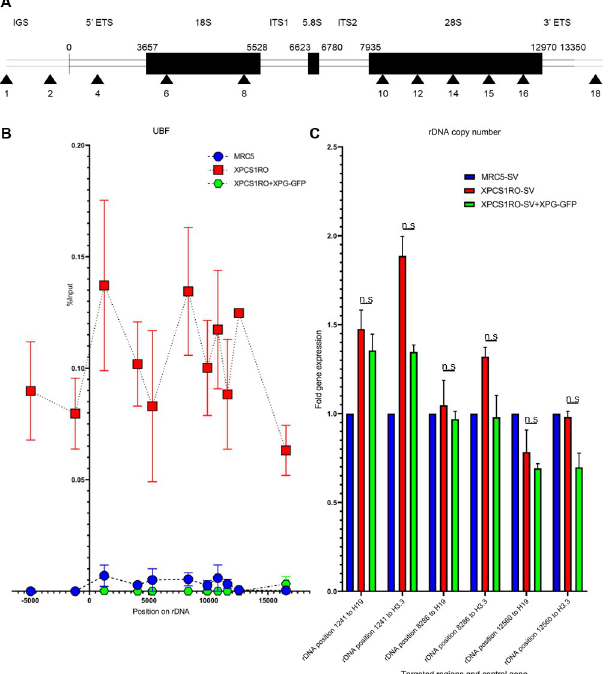
Fig 2. The absence of a stable XPG protein leads to an increased binding of UBF along rDNA unit. A) Scheme of the human rDNA unit with the position of all the primers used. IGS: InterGenic Spacer; ETS: External Transcribed Spacer; ITS: Internal Transcribed Spacer. B) ChIP-qPCR using UBF antibody in MRC5-SV, XPCS1RO-SV and XPCS1RO-SV+XPG-GFP cell lines. Signal was quantified as percentage of input DNA. Error bars represent the SEM of two independent experiments. C) Fold gene expression of three rDNA regions, relatively to two housekeeping genes, in MRC5-SV, XPCS1RO-SV and XPCS1RO-SV+XPG-GFP cell lines. The error bars represent the SEM of 3 biological replicates. Statistical significance was determined using the Holm-Sidak method in GraphPad Prism 8.1.0, with ⍺ = 0.05. n.s: Not significant.